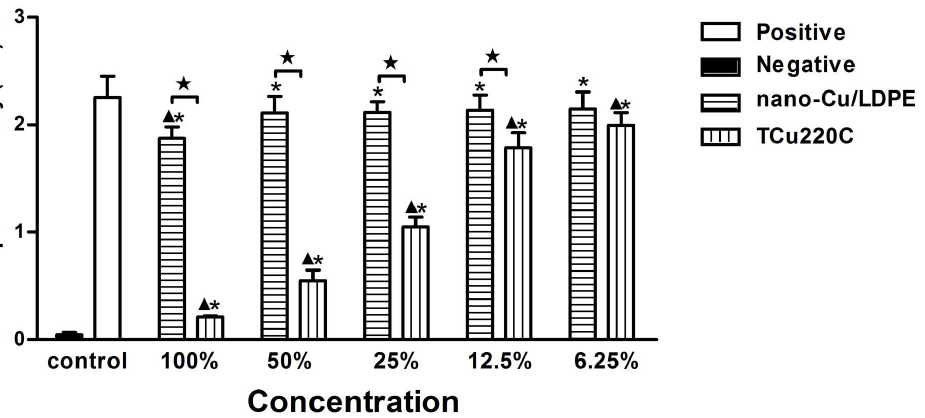
Figure 2. The OD values of the extracts of the nano-Cu/LDPE and TCu220C IUD for 3 d. * p , .05 compared with the positive group; m p , .05 compared with the negative group; w p , .05 between two groups.